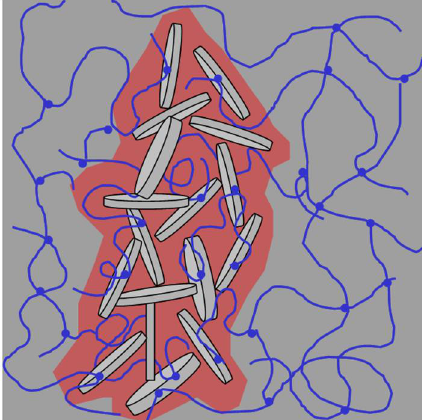
Figure 10. Illustration of possible double-network structure in silanized hydroxypropylmethylcellulose (Si-HPMC)/Laponite composite hydrogel. The curve line represents Si-HPMC polymer chain, the little plates represent Laponite and the round dots represent crosslink point where silanol condensation occurred. The silanols come from both Si-HPMC and Laponite. As Laponite has been dyed by Auramine O, the compact mass composed of aggregated Laponite and entangled polymer chain is in red under CLSM. It is likely that the XLS aggregates are more random than purely edge-faces contacts.